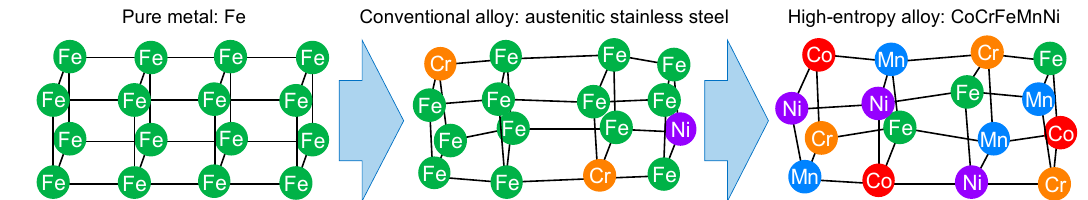
Figure 1. Schematic of the atomic lattices of metals and alloys.